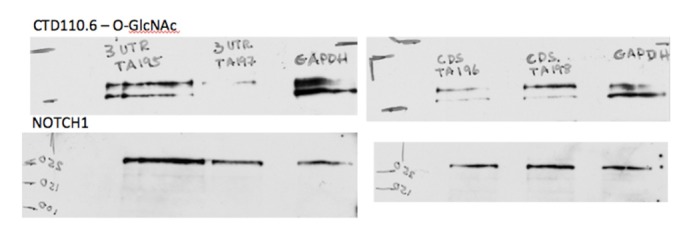
DOI:
http://dx.doi.org/10.7554/eLife.24419.026